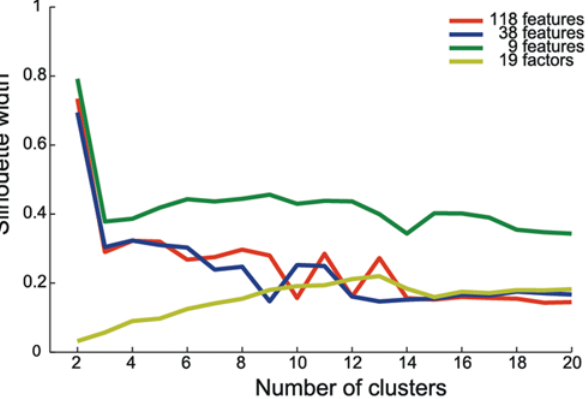
Fig 3. Comparison between the average silhouette width for K-means clustering for k = 2 to 20 clusters for all 4 feature sets. The 9 feature set (green) shows generally higher silhouette width. For the 2-cluster-solution, all but the set based on factors (yellow) show globally the highest value. Excluding the 2-cluster-solution (not to be retained because of its lack of detail), no solution is markedly superior over all others, although plateau values of average silhouette width are already obtained for cluster numbers as small as k = 5 (apart from factor-based clustering).